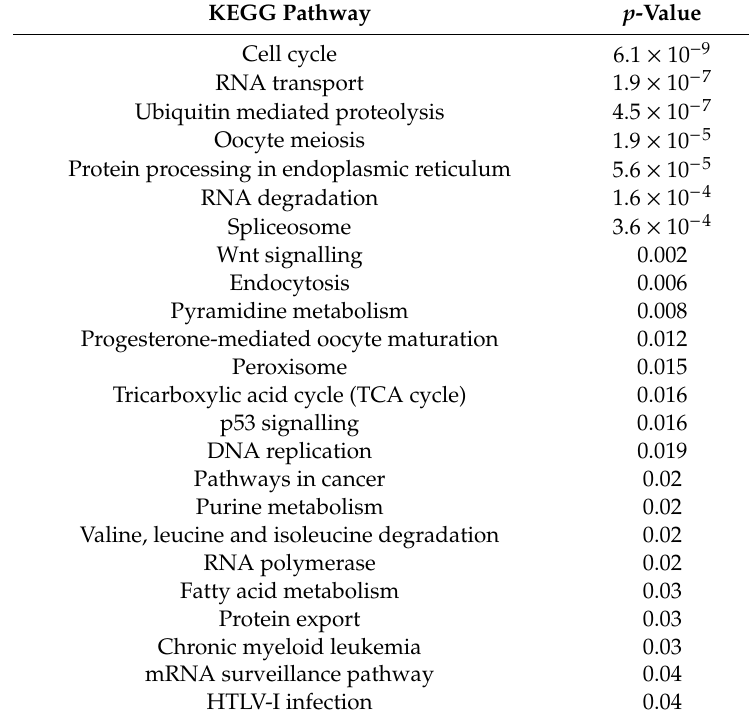
Table 3. KEGG pathway analysis of all significantly downregulated genes in response to hypoxia in human